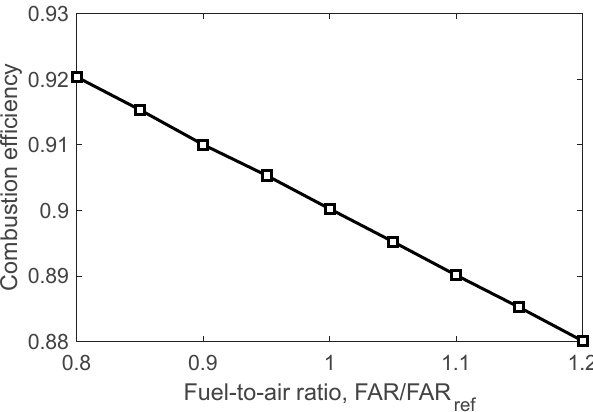
Figure 14. Effect of the fuel-to-air ratio on the combustion efficiency. Figure 14. E ff ect of the fuel-to-air ratio on the combustion e ffi ciency.